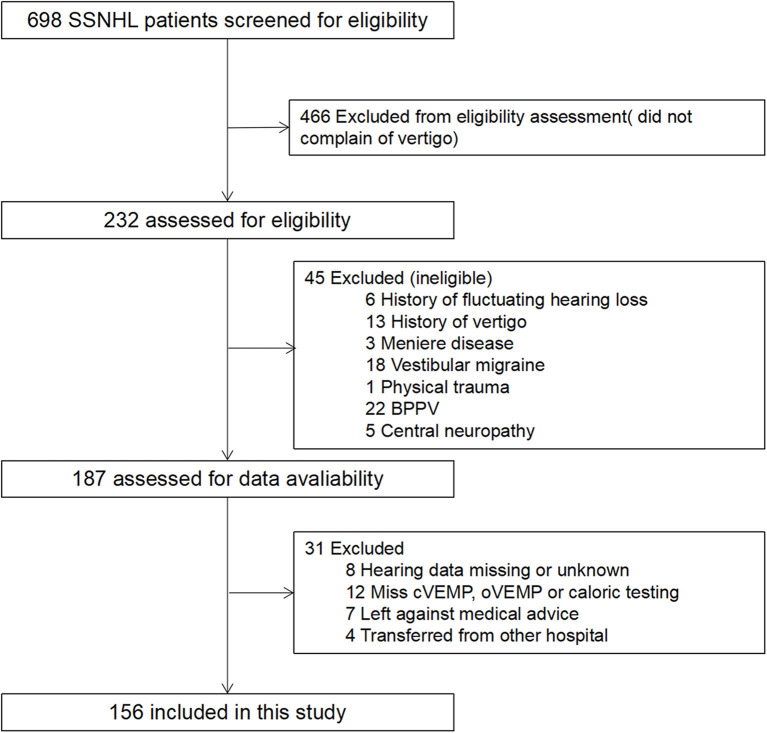
Flow diagram showing study patients screening, eligibility, and inclusion.